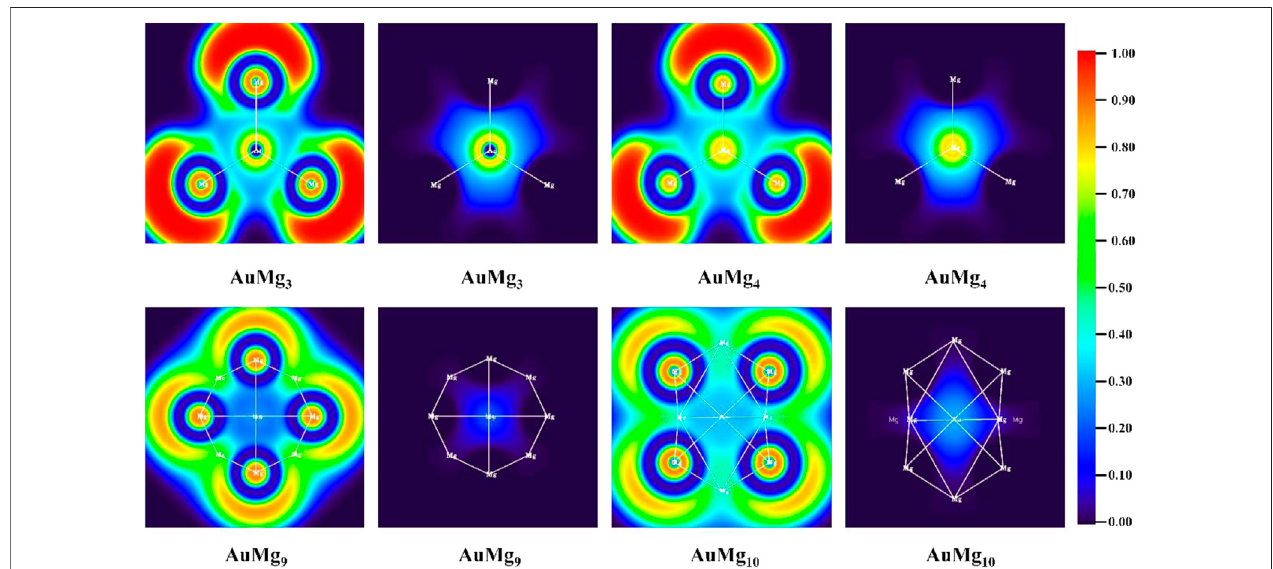
FIGURE 5 | The ELF analysis for Mg-Mg and Au-Mg chemical bonds for AuMg n ( n = 3, 4, 9, 10) nanoclusters.